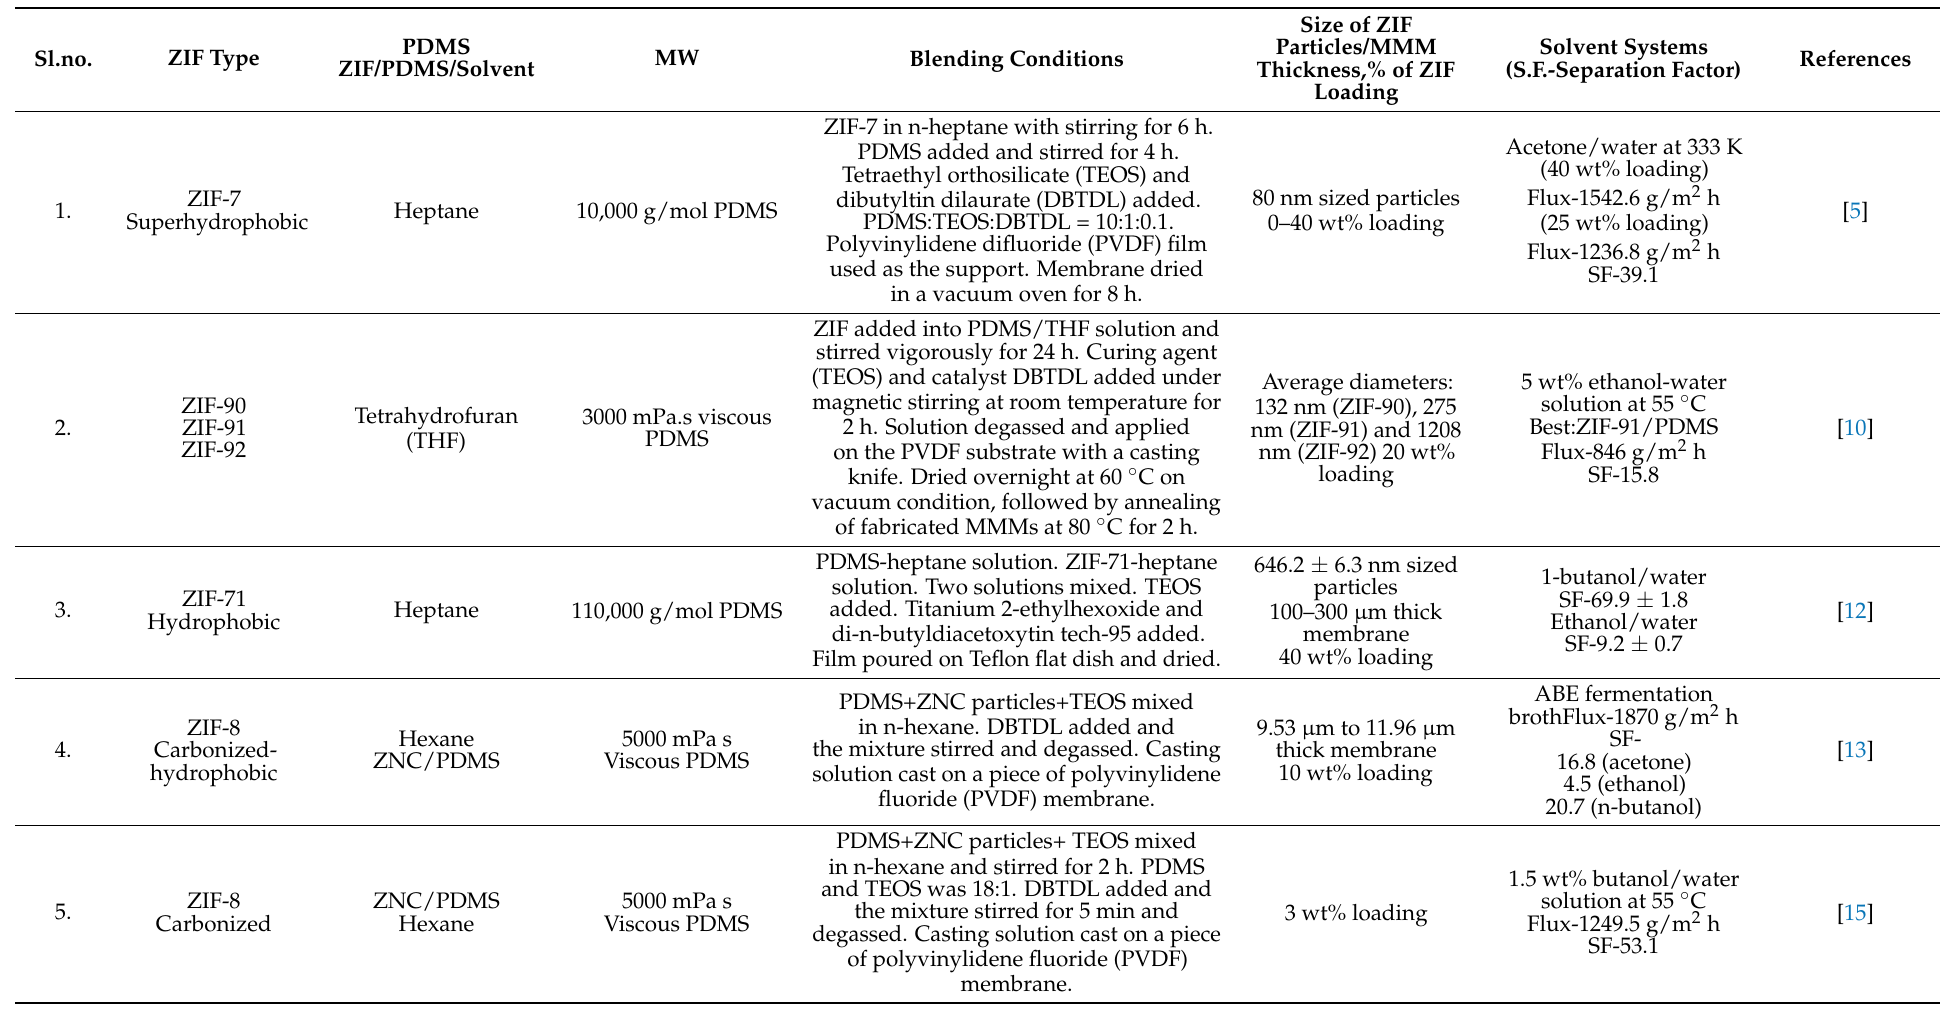
Table 1. ZIF-PDMS mixed matrix membranes’ blending conditions, membrane characteristics and separation performance.